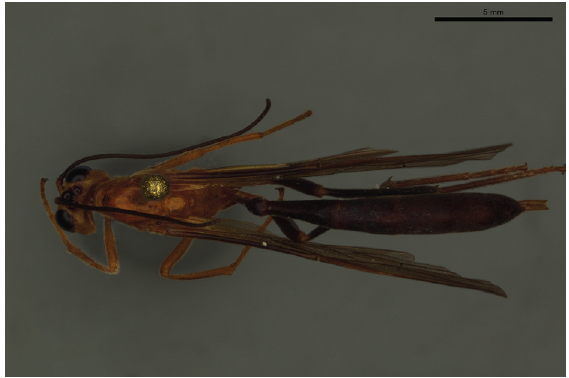
Figure 5 - Castrosion renei gauld & Bradshaw, 1997, female metasoma, dorsal